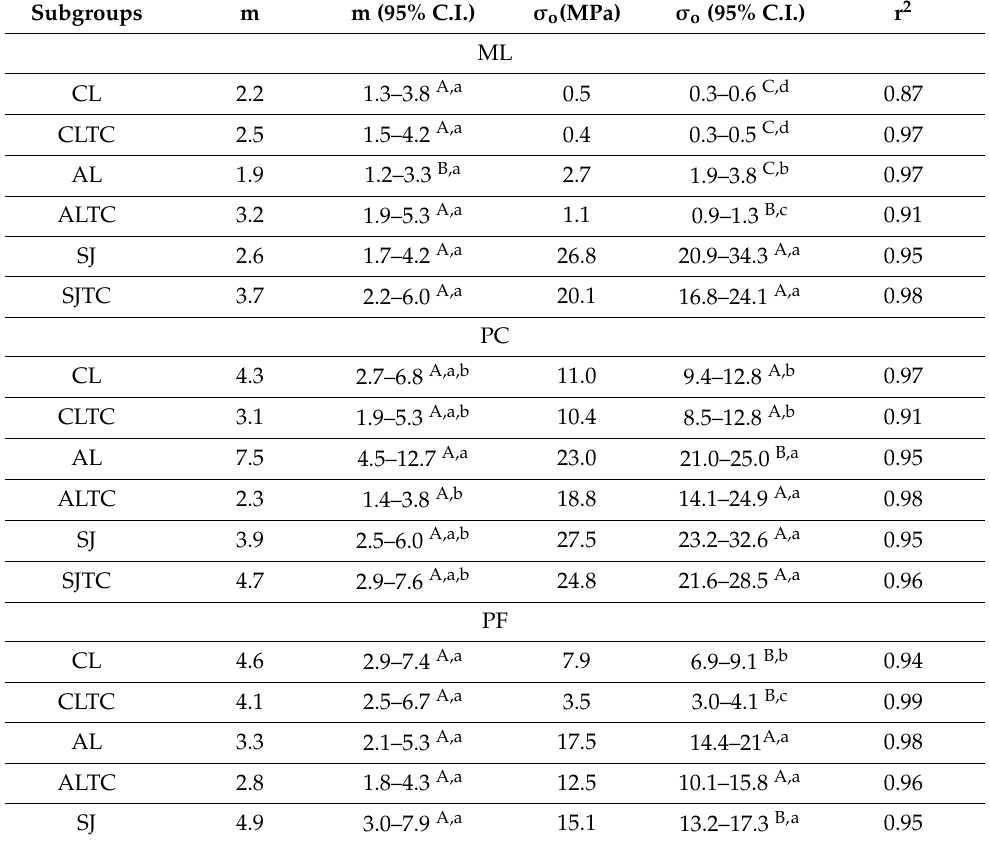
Table 3. Results of the Weibull modulus (m) and scale ( σ o ) parameters, with the corresponding 95% confidence intervals (C.I.) and the regression coefficient (r 2 ) for materials, treatments and storage conditions (before and after thermal-cycling/TC) Same superscripts indicate values with no statistically significant difference ( p > 0.05) within the same treatment between the cements (upper case) and the various treatments for the same cement (lower case). Subgroups m m (95% C.I.) σ o (MPa) σ o (95%